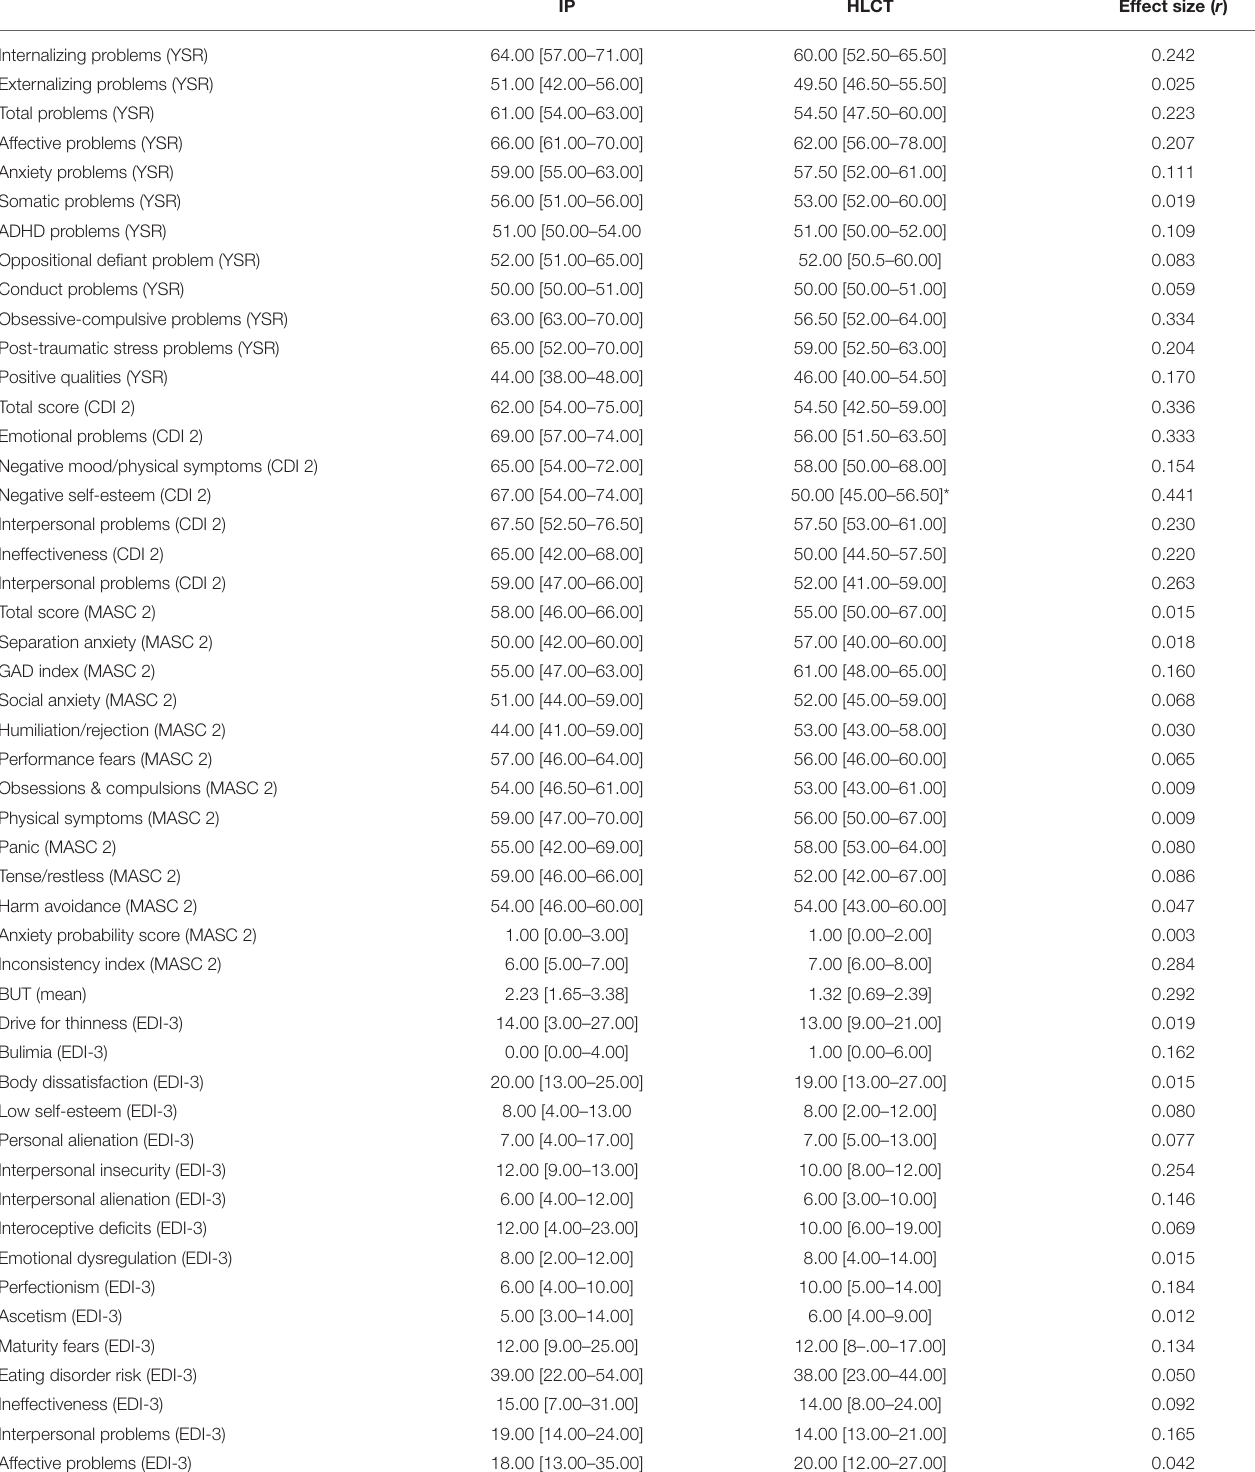
TABLE 3 | Patients’ psychopathological characteristics in IP and HLCT groups at